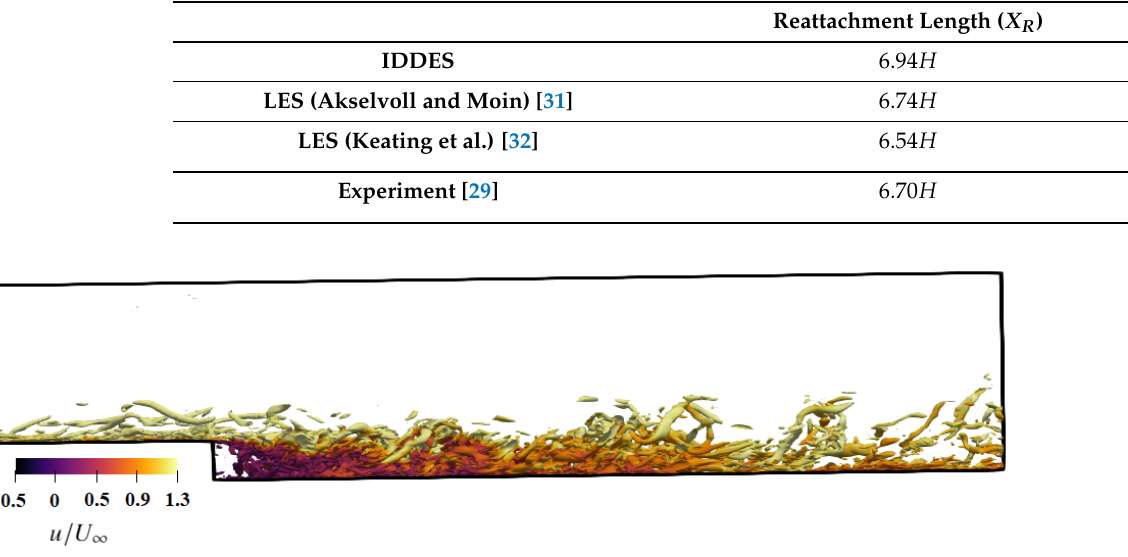
Figure 3. Iso-surface of Q-criterion colored by the instantaneous streamwise